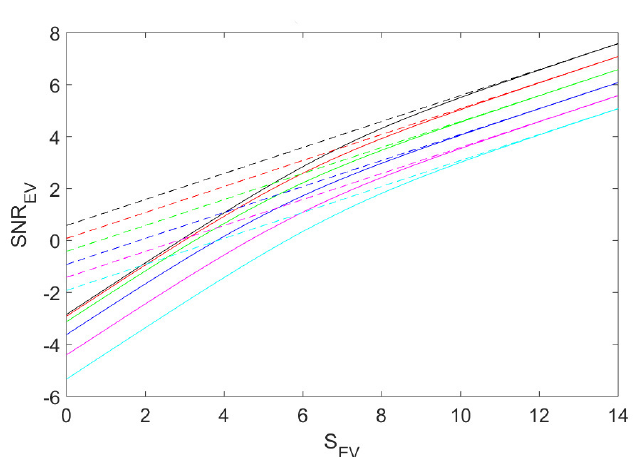
Figure 3. Ideal (dashed lines) and real (solid lines) SNR curves for a Canon 50D. Black, ISO 100; red, ISO 200; green, ISO 400; blue, ISO 800; magenta, ISO 1600; cyan, ISO